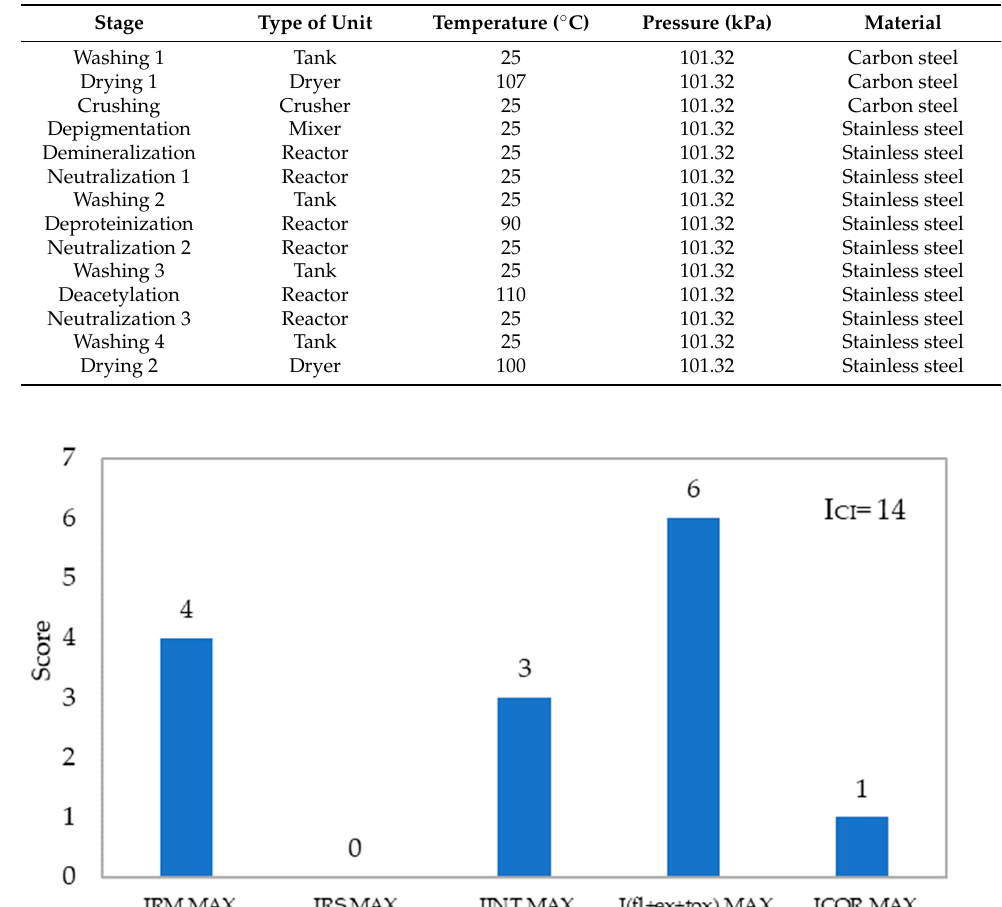
Table 4. Description of the main equipment used for chitosan production from shrimp exoskeleton.